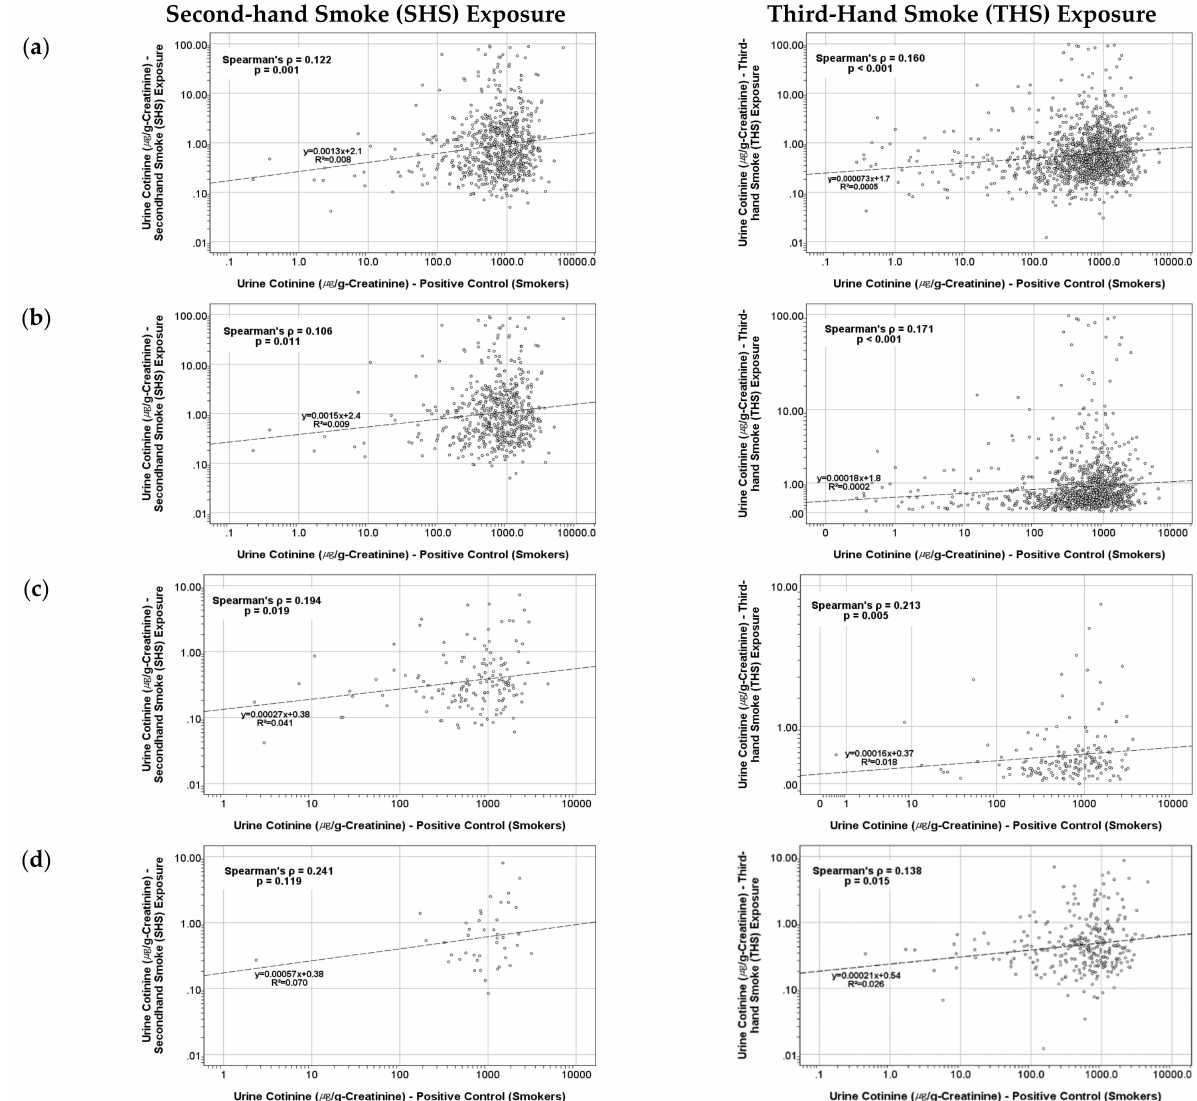
Figure 2. Correlation of urine cotinine levels of active and passive smokers living in the same family according to the age of the passive ETS exposure subjects: ( a ) all ages, ( b ) adults (age ≥ 19), ( c ) adolescents (ages 12–18), and ( d ) children (ages